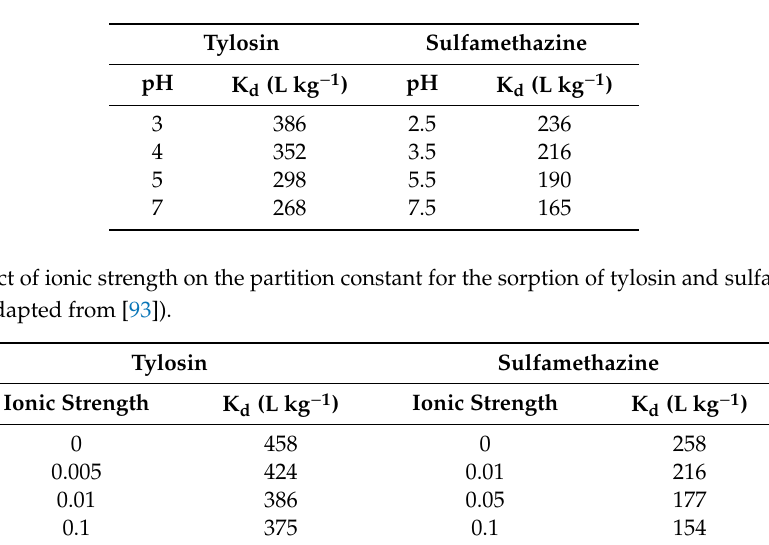
Table 3. E ff ect of pH on the partition constant for the sorption of tylosin and sulfamethazine (adapted from [93]).